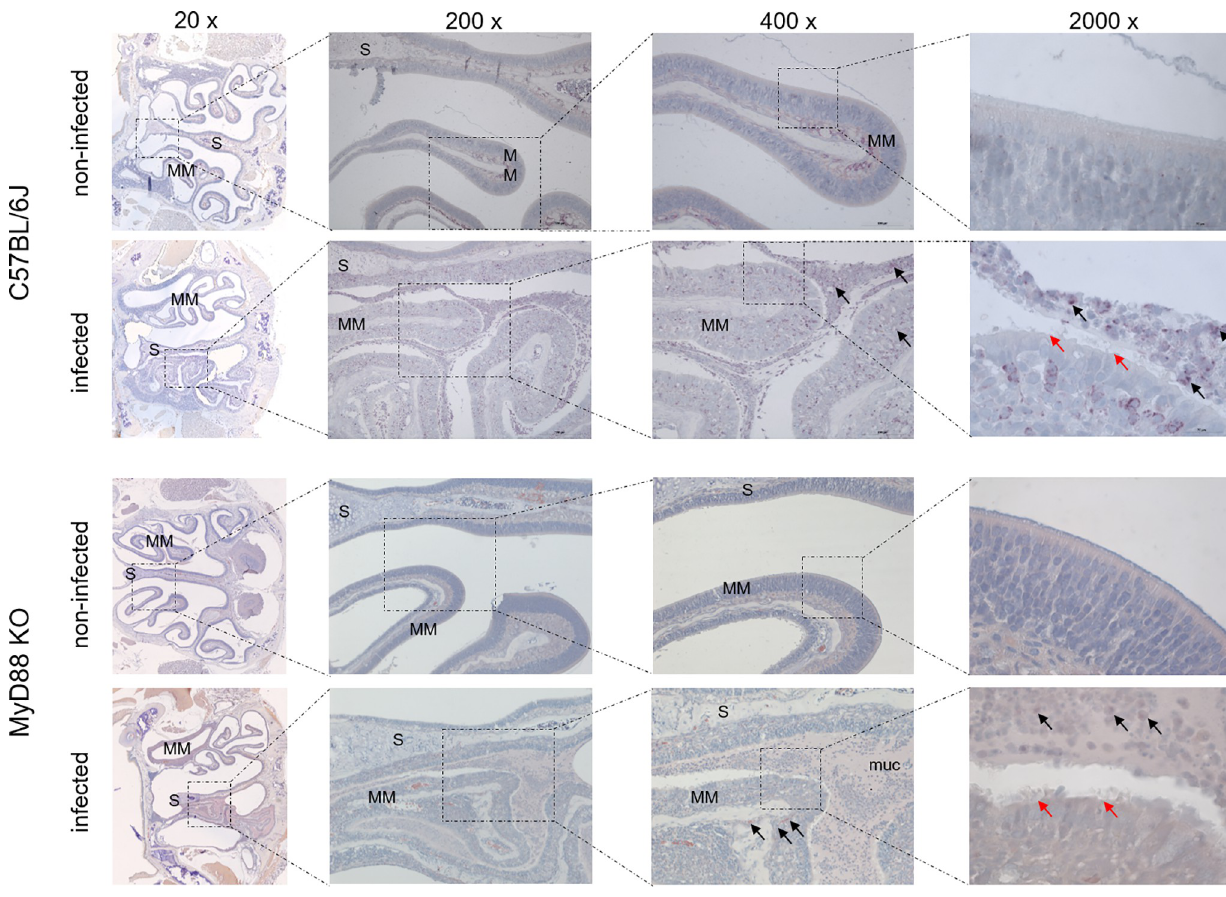
Fig 7. Neutrophil infiltration in the nasal cavity of B . pertussis -infected mice. NASDCL histochemistry detection of neutrophils. Representative images of NASDCL-stained level 2 coronal sections through the nasal cavity of MyD88 KO and C57BL/6J mice on day 7 after inoculation of nares with 5 μ l of suspension containing 10 7 or 10 9 CFU of B . pertussis bacteria, respectively. The black arrows point to neutrophils present in high numbers in the mucopurulent exudate. The red arrow points to the disrupted layer of epithelium with loss of cilia. 3 mice per group were used and representative images of stained sections are